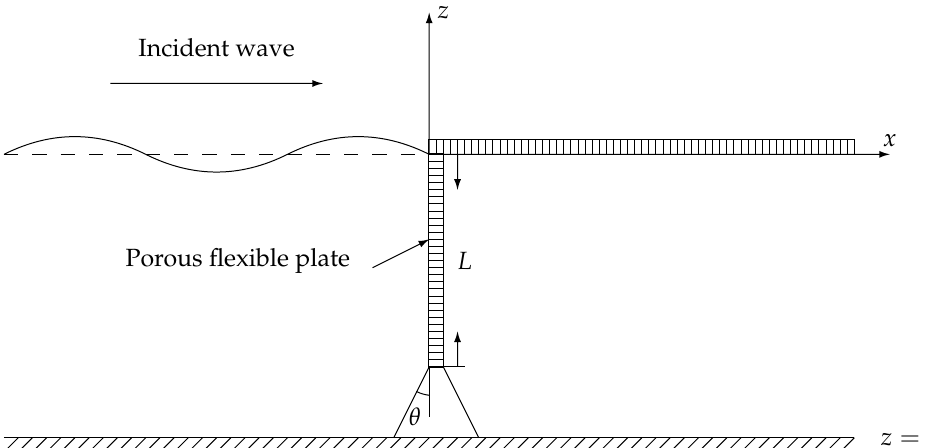
Figure 1. Schematic diagram for the wave scattering by a semi-infinite elastic plate in a single- layer